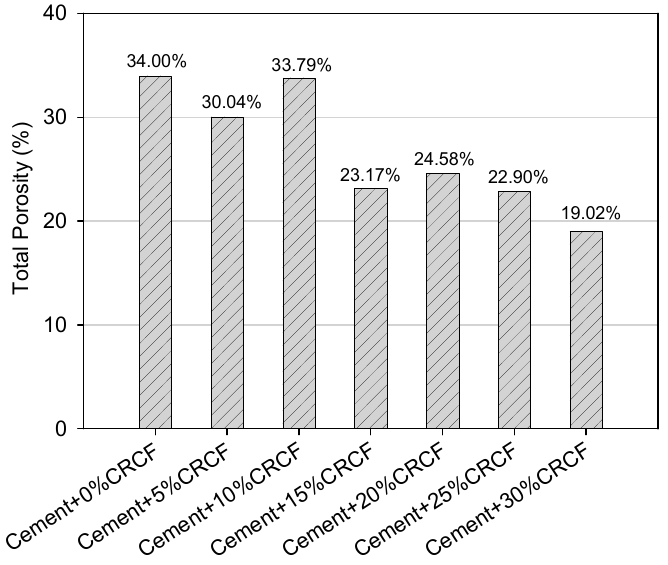
Figure 19. Total porosity of hardened cement pastes in relation to CRCF content.